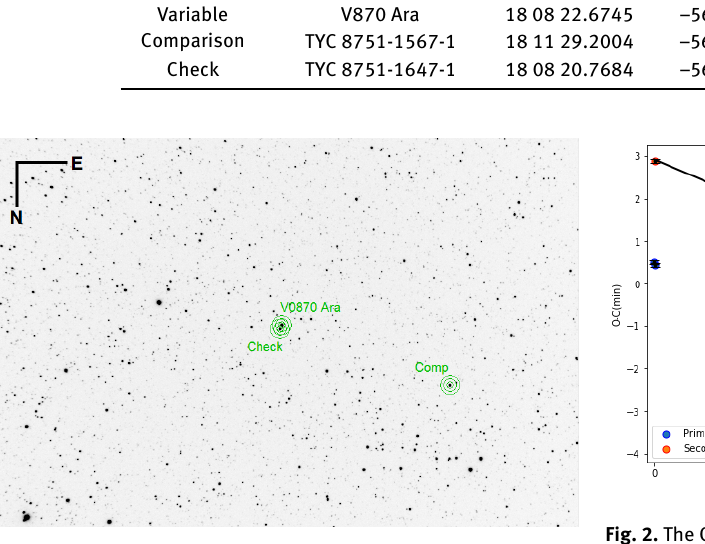
Fig. 1. The position of V870 Ara, TYC 8751-1567-1 (comparison star), and TYC 8751-1647-1 (check star). The field of view is 90 by 72 arcminutes. The circles are only to indicate the position of each star with much larger rings. The aperture radius used for photometry was 8 pixels, gap width 5 pixels and annulus thickness 5 pixels.